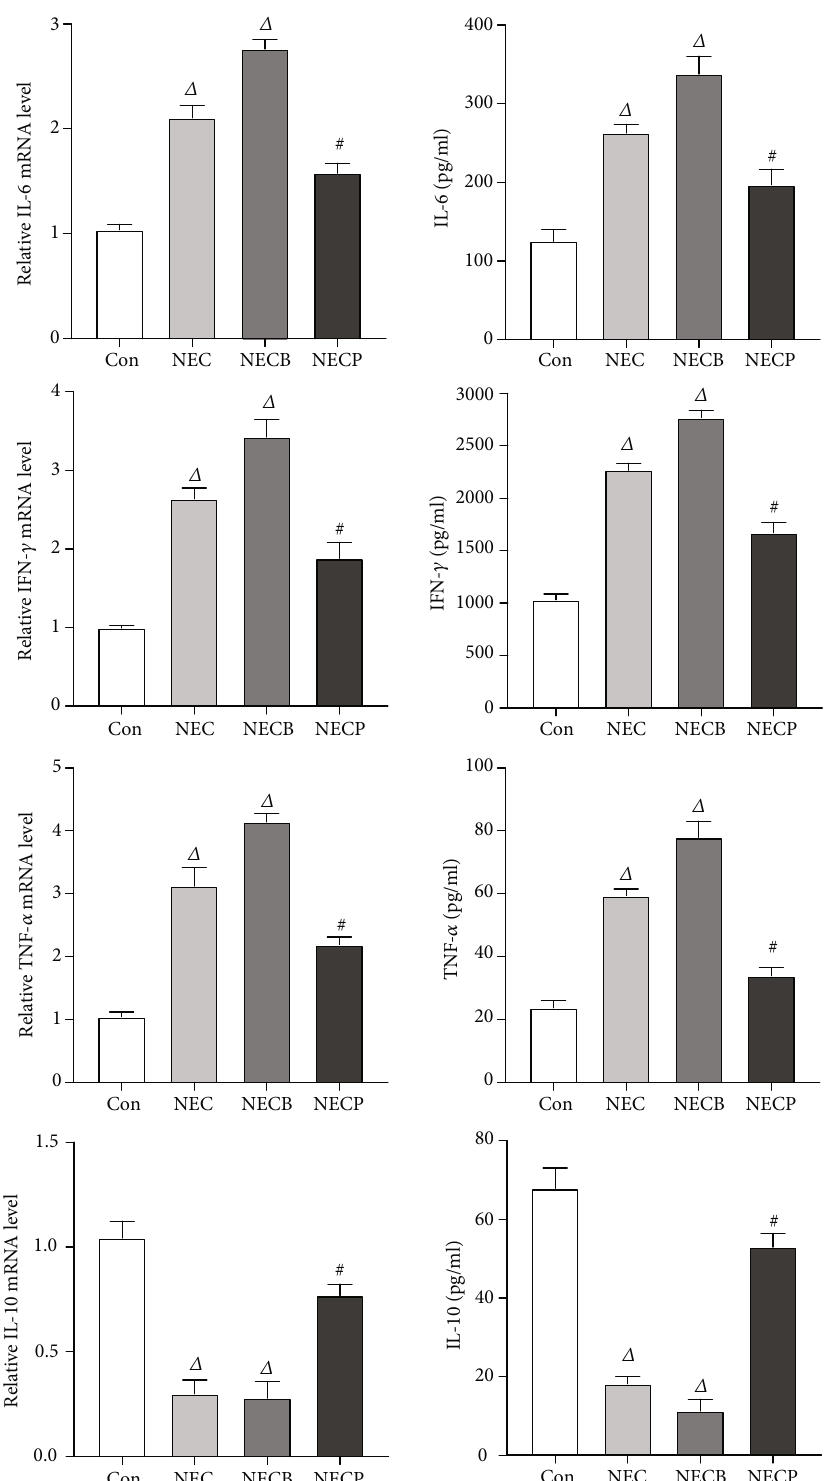
Figure 5: Inhibition of A R by PSB1115 attenuated in fl ammation in NEC rats. Proin fl ammatory (IL-6, IFN- γ , and TNF- α ) and anti- 2B in fl ammatory (IL-10) cytokines were measured by ELISA assays. NEC: necrotizing enterocolitis; NECB: necrotizing enterocolitis+BAY60- 6583 treatment; NECP: necrotizing enterocolitis+PSB1115 treatment. Δ p < 0 : 01 vs. all other groups; # p < 0 : 001 vs. the Con